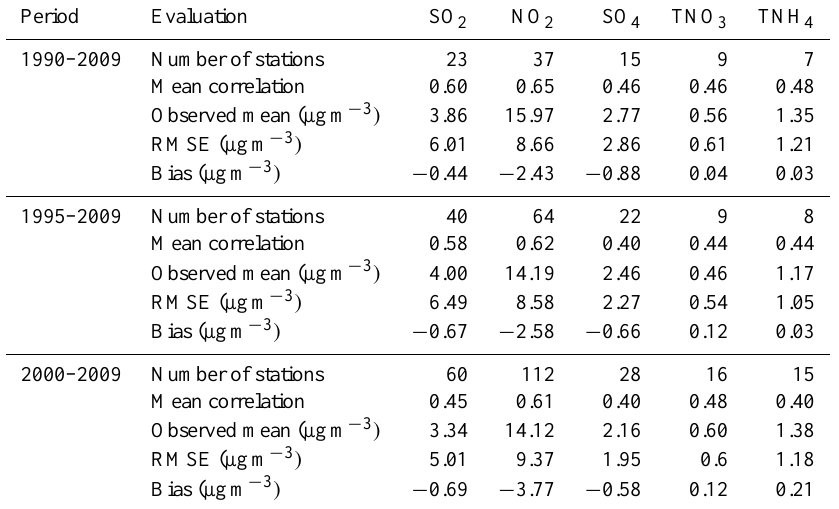
Table 4. Statistical comparison between measured and modelled concentrations using daily observations. The number of considered stations, mean correlation, observed mean, RMSE and bias are given for each component and each time period.